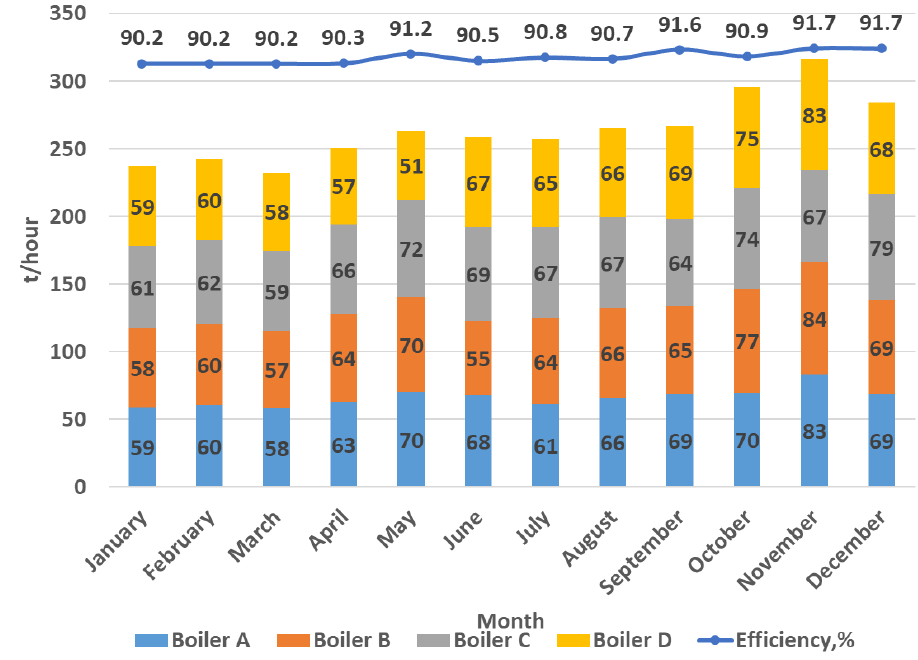
Figure 12. Steam generation by boilers and their efficiency per year.